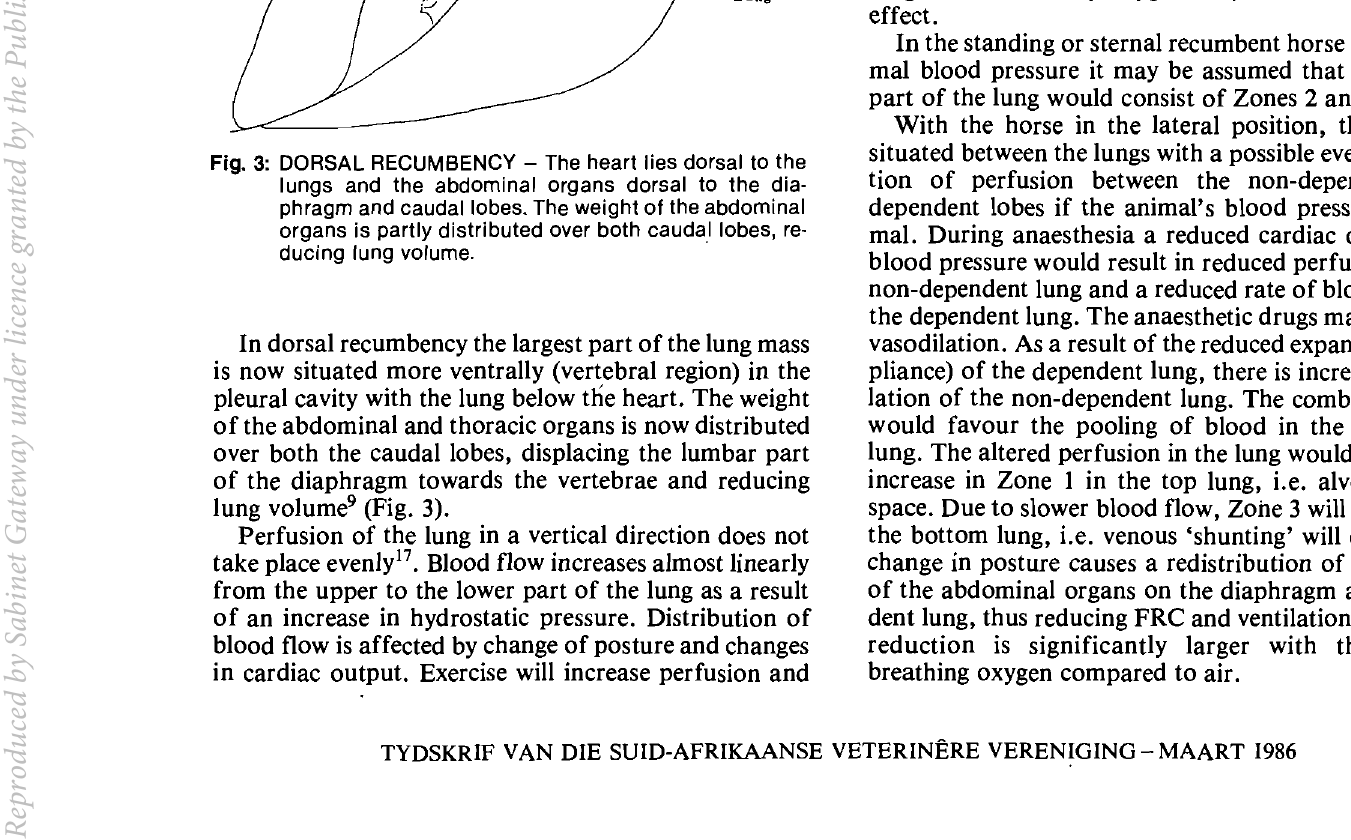
Fig. 2: LATERAL RECUMBENCY - The heart is situated mid way between the non-dependent and dependent lung_ The weight of the abdominal organs is partly distribu ted over the caudal lobe of the dependent lung, re ducing lung volume.